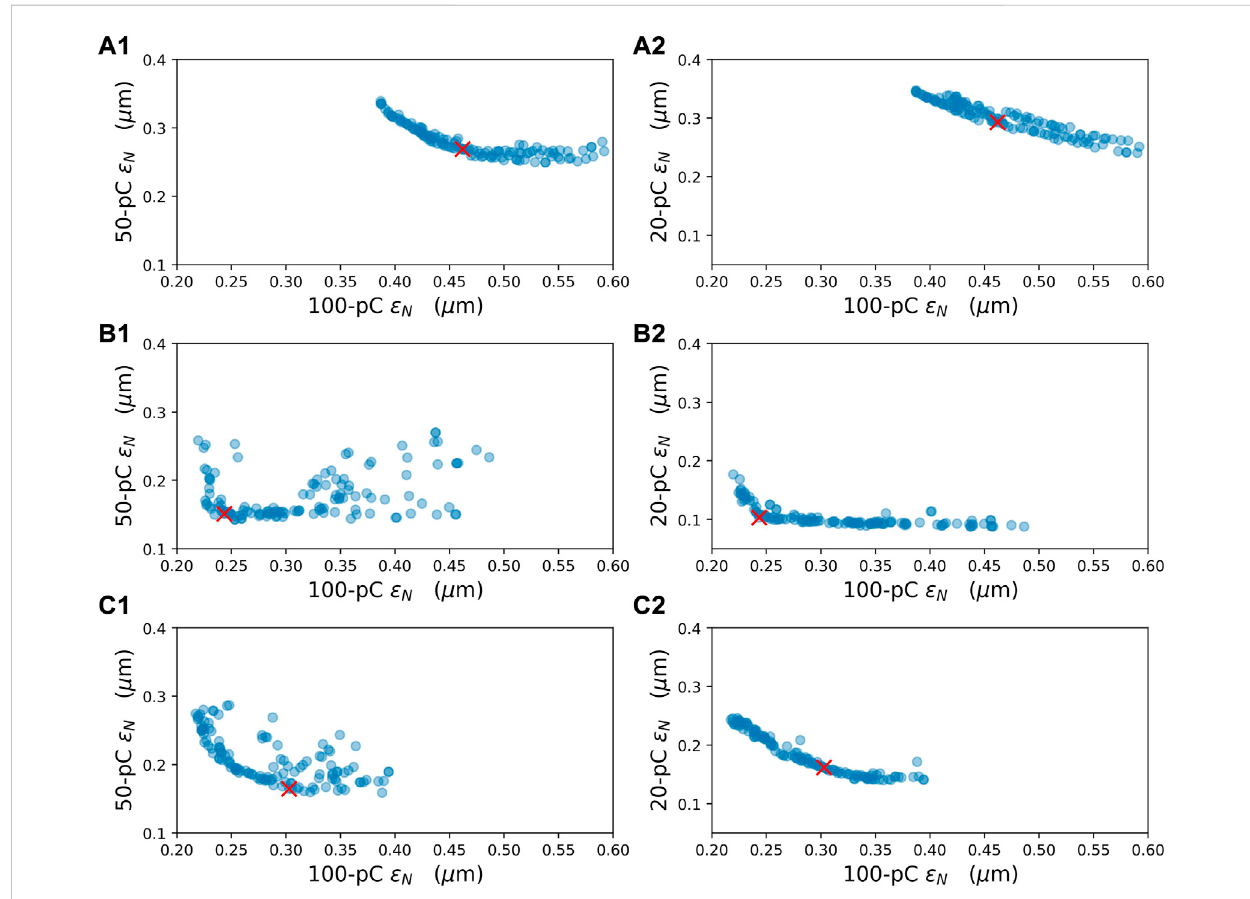
FIGURE 4 Distribution of beam emittance between 100 pC and 50 pC (left column), 100 pC and 20 pC (right column) in the multiplexed con fi guration. The desiredrmsbunchlengthis1.0±0.1 mmfor100 pC,0.8±0.1 mmfor50 pCand0.6±0.1 mmfor20 pC,respectively,inthelossfunctions.(Top)case (A) no customized knob. (Middle) case (B) customized laser spot size. (Bottom): case (C) customized laser pulse duration. The red cross represents the optimal point with minimum sum of the emittance of three beam charges in each con fi